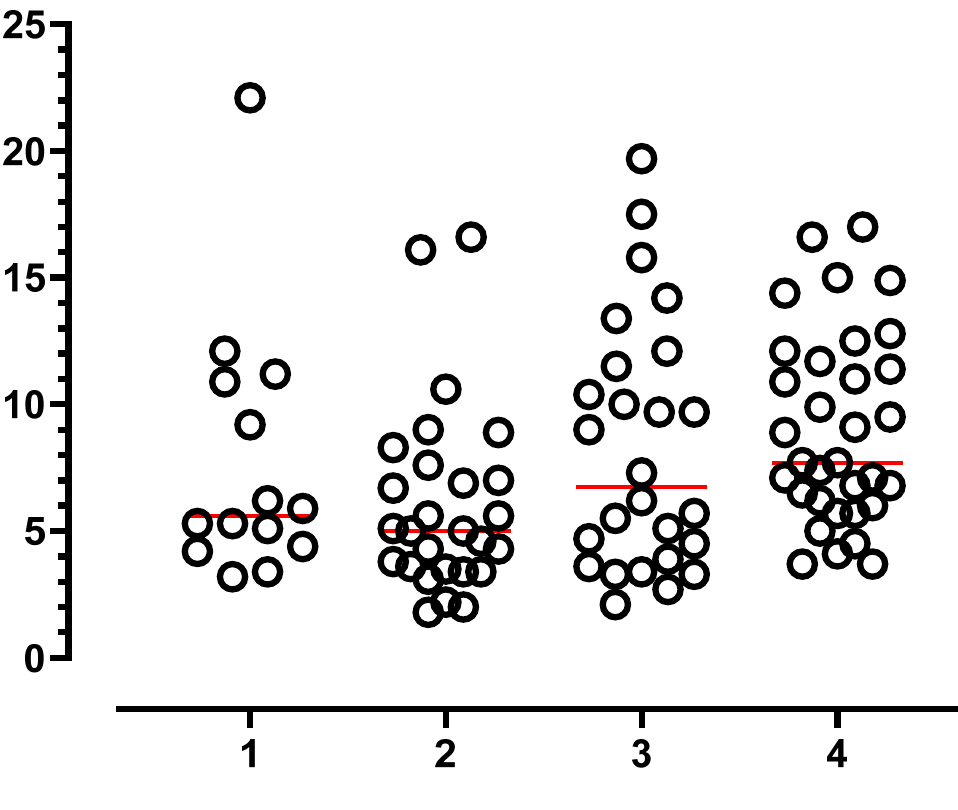
Figure 6. Depth of vessels in 14 participants measured at hot spot locations using ultrasound calipers. Measurements taken from skin surface to vessel base. First appearing hot spots, (time 1). Thereafter, a further 5–6 spots in each colour category (blue, gold, green) were selected from the map (see Figure 4A); T2, vessel depth of spot/s appearing within 3 min; >3–6 min (T3); spot appearance >6–10 min (T4). Horizontal lines indicate median values.